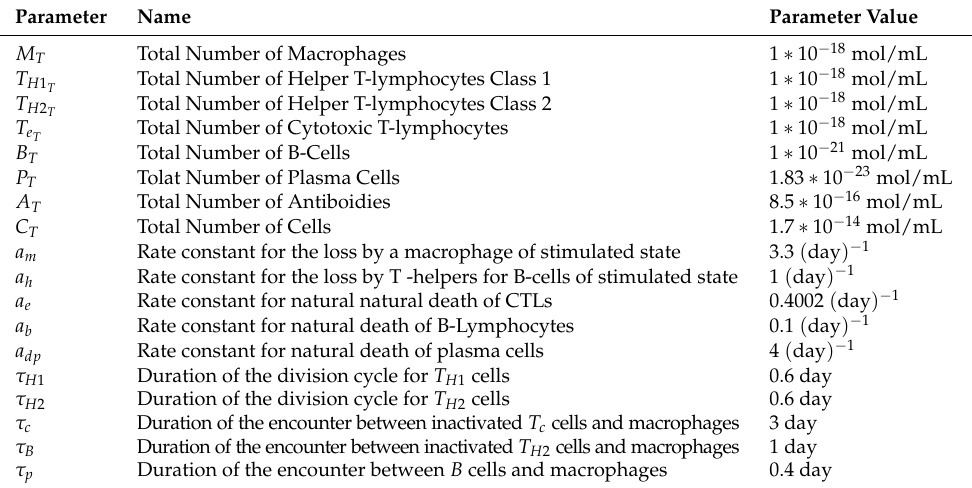
Table 2. Parameters used in the model.